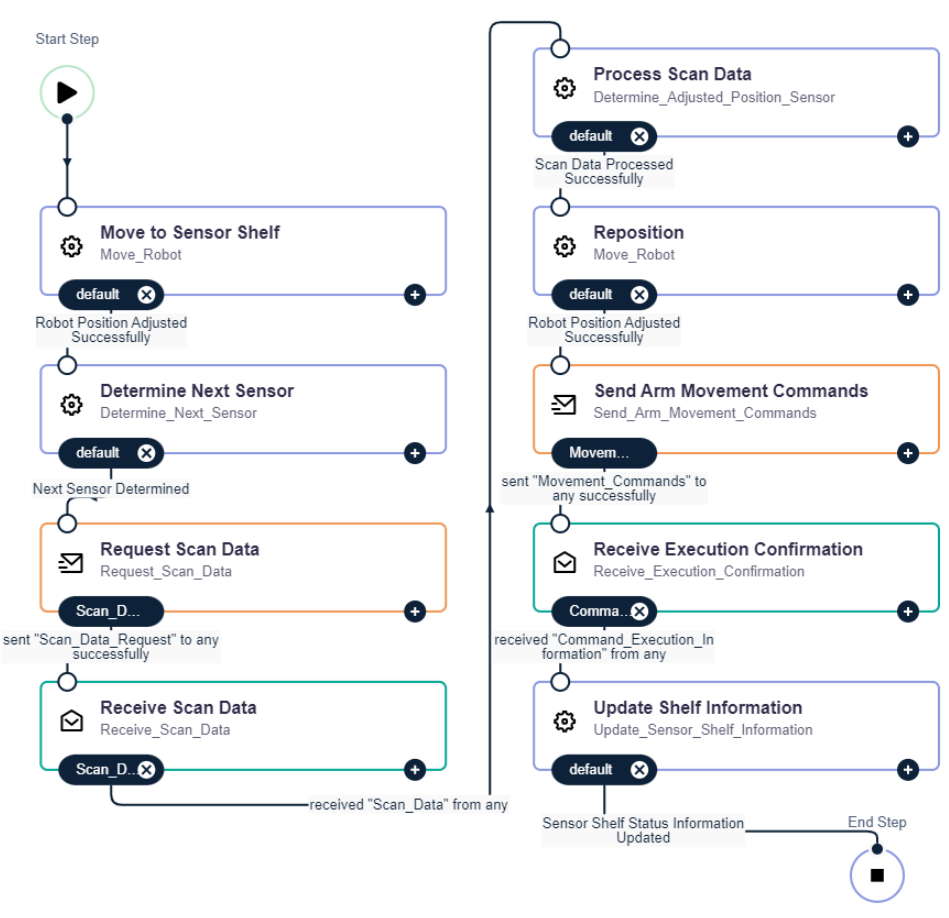
Figure 6. Vaccine logistics illustration case - Robot behavior during step 4 of transport preparation process (selection of a